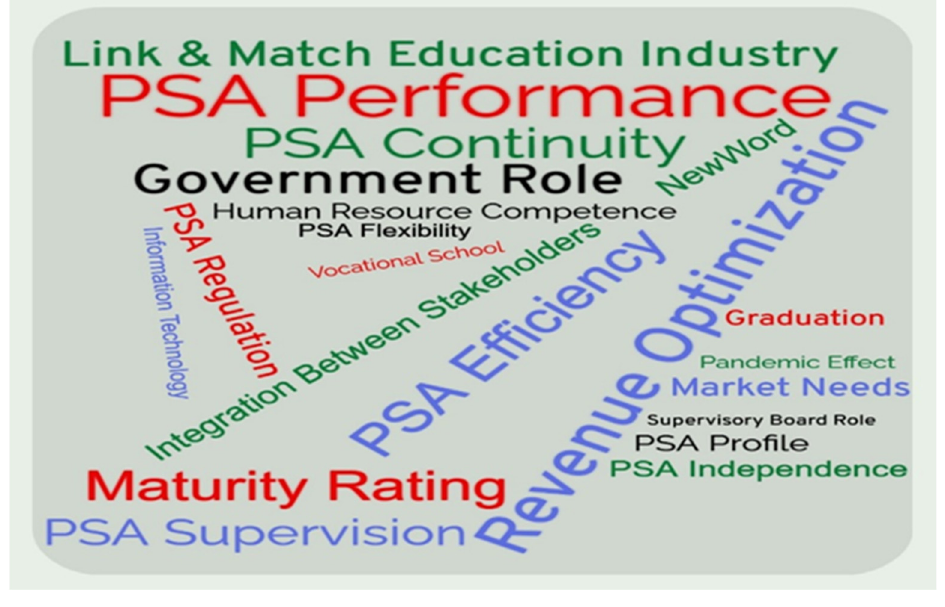
Figure 2. Hierarchy Aggregate.